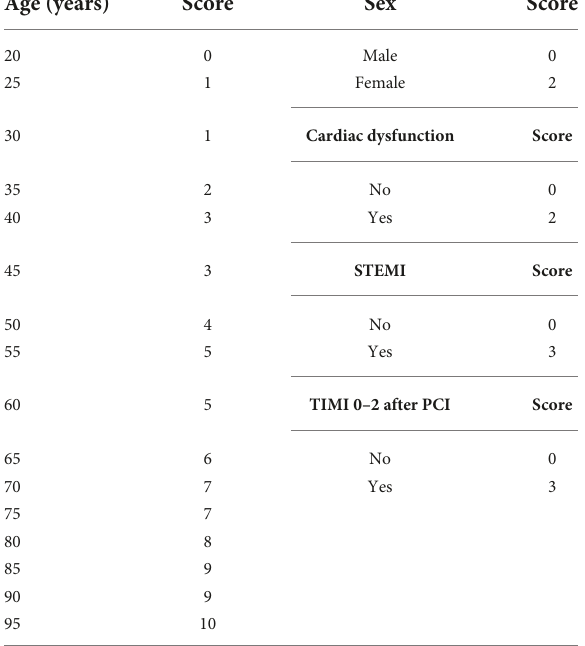
TABLE 3 Risk-prediction